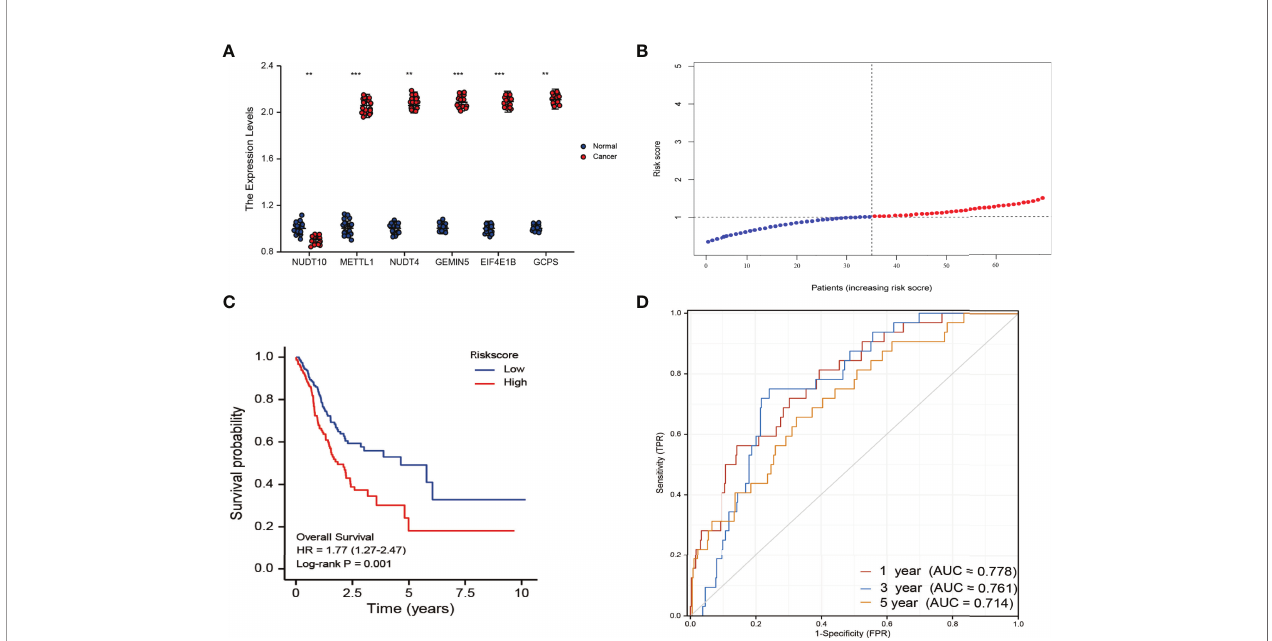
FIGURE 5 | (A) Results of qRT-PCR analysis. *p < 0.05; **P <0.01; ***p < 0.001 (B) The distribution and median value of the risk scores in the derivation cohort. (C) Kaplan-Meier curves for the OS of patients in the high-risk group and low-risk group in the validation cohort. (D) AUC of time-dependent ROC curves veri fi ed the prognostic performance of the risk score in the validation cohort.